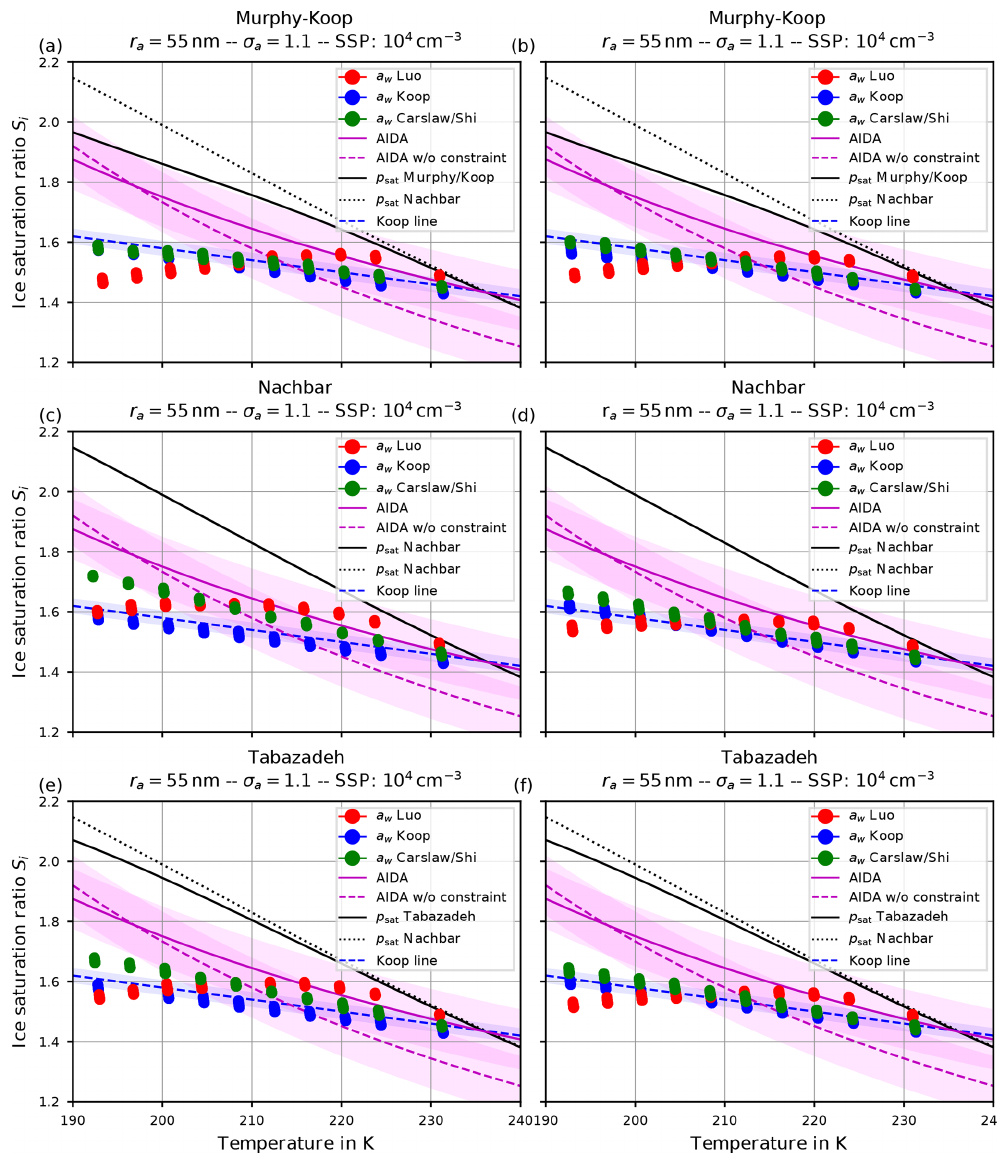
Figure 12. (a, c, e) Ice onset humidities as computed by fixing Carslaw’s method within the routine computing the Köhler equilibrium and using a i w as in Koop et al. (2000). (b, d, f) Same as for (a, c, e) but a i w is computed by using the quotient p i , sat panels is as in Fig.